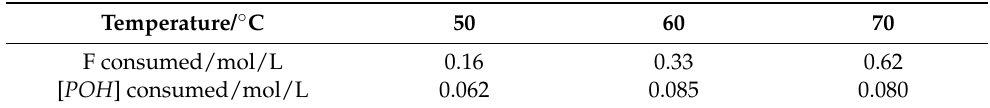
Table 5. Comparison between the consumption of formaldehyde and phenolic hydroxyl groups type I and II in the methylolation of HLS at 50, 60, and 70 ◦